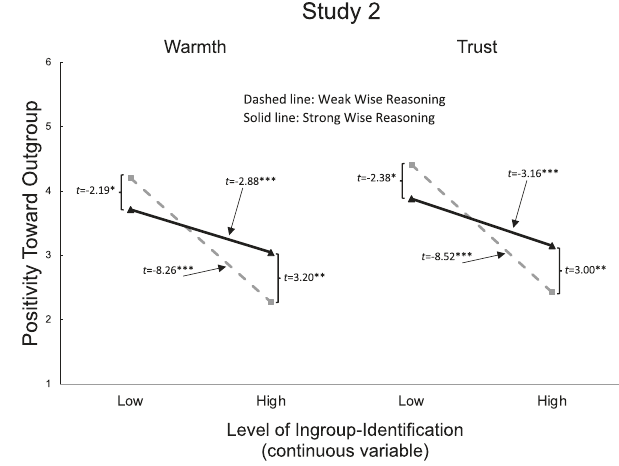
Fig. 2 Results from Study 2: positivity toward target group as a function of the strength of participants ’ self-reported ingroup-identi fi cation (a continuous variable) and their level of wise reasoning. Comparisons of strong and weak wise reasoning as well as high and low identi fi cation are presented at the level of ±1 standard deviation from the mean. M